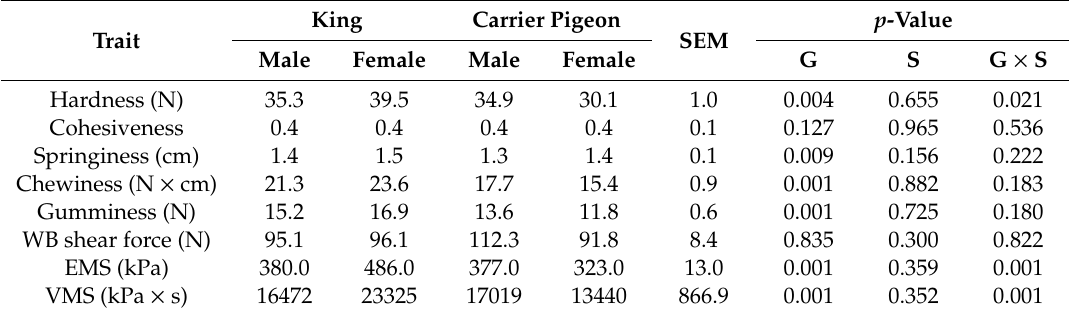
Table 5. Texture and rheological properties of the pectoralis major muscle in three-year-old pigeons of di ff erent genotypes.